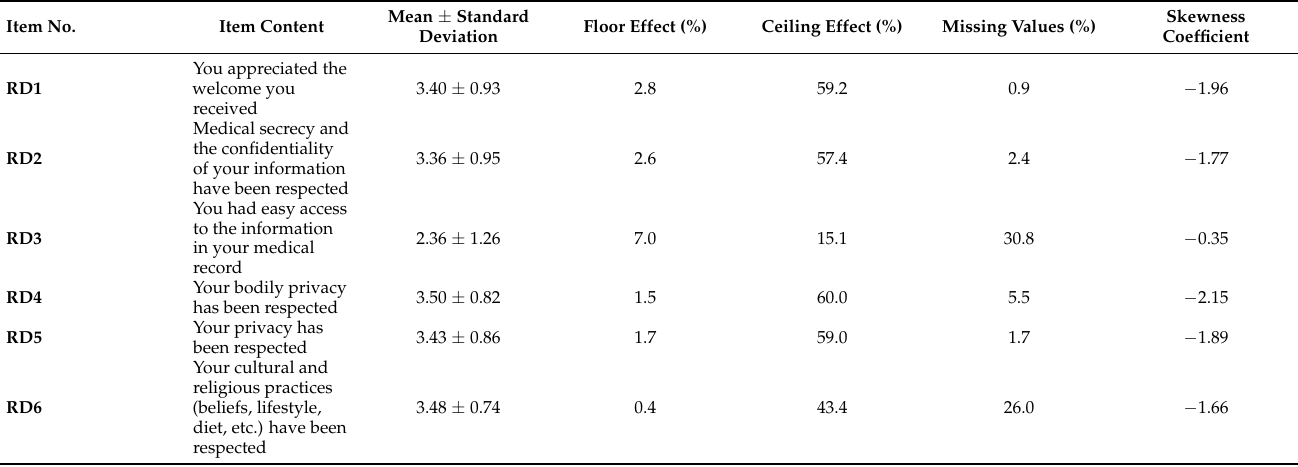
Table 2. Descriptive statistics of the PREMIUM-RD item